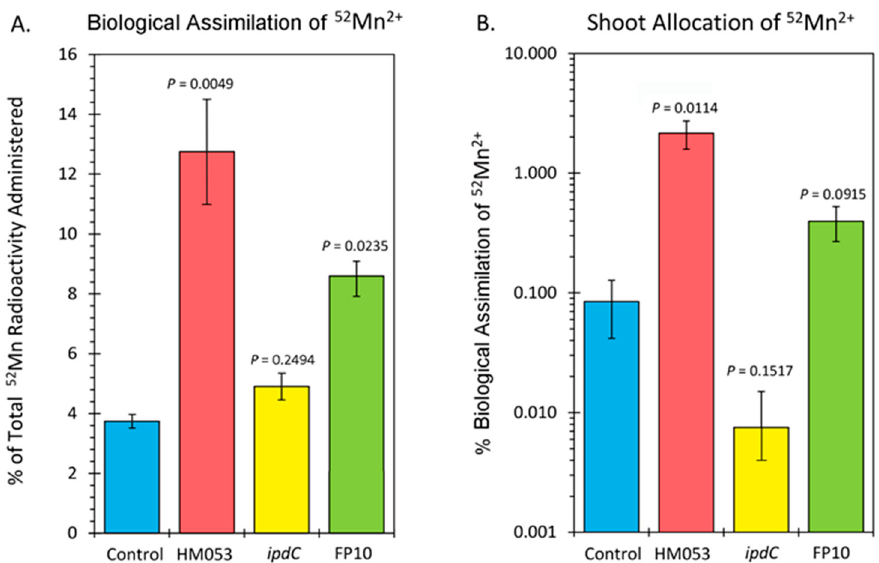
Figure 3. Summary of 52 Mn 2+ uptake studies. Panel ( A ): biological assimilation of 52 Mn 2+ radiotracer over 3 h representing the combined actions of microbial and host plant assimilation. Panel ( B ): allocation of assimilated 52 Mn 2+ to the shoots of the host plant. Data bars reflect mean values ± SE. The number of biological replicates was defined by the number of plants we examined per treatment (control, N = 6 plants; HM053-inoculated, N = 6 plants; ipdC -inoculated, N = 4 plants; FP10, N = 6 plants). p values < 0.05 were considered statistically significant.